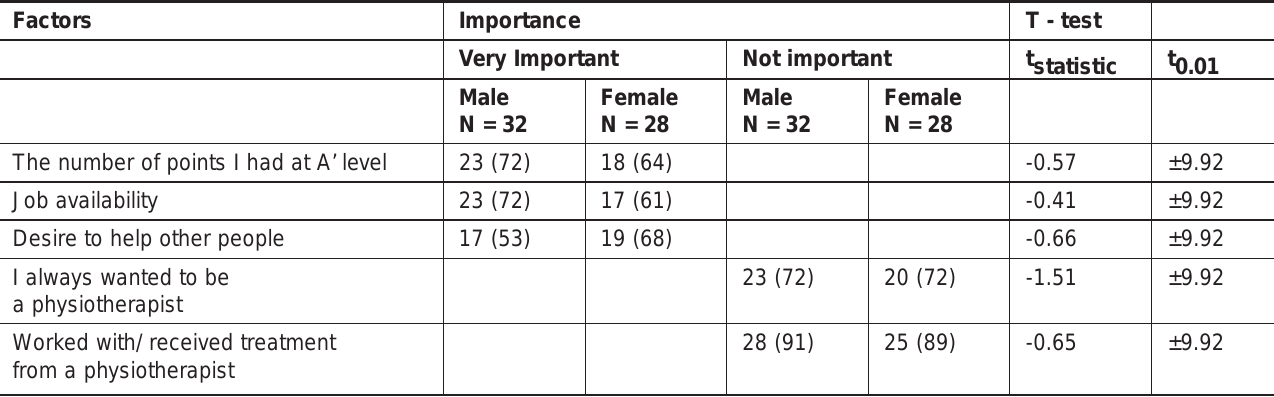
Table 1: Illustration of the ranking of importance of factors which influenced the decision to pursue physiotherapy as a gender.Factors Table 2: Illustration of ranking by